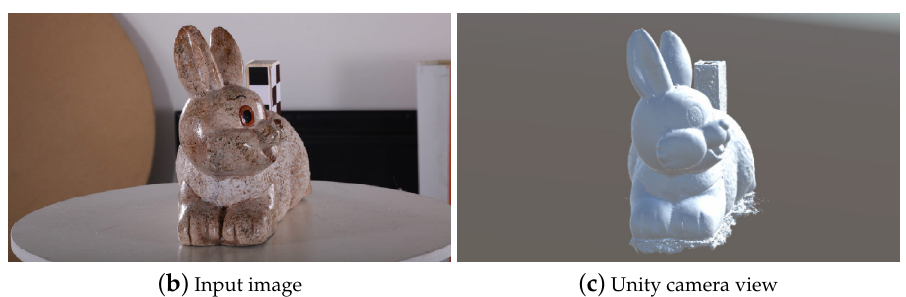
Figure 8. Views from the Unity implementation used for the capturing setup-based metric